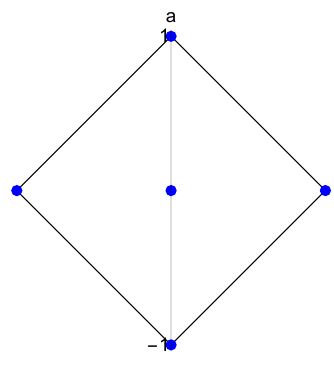
Figure 2 . Homological diagram for 4 1